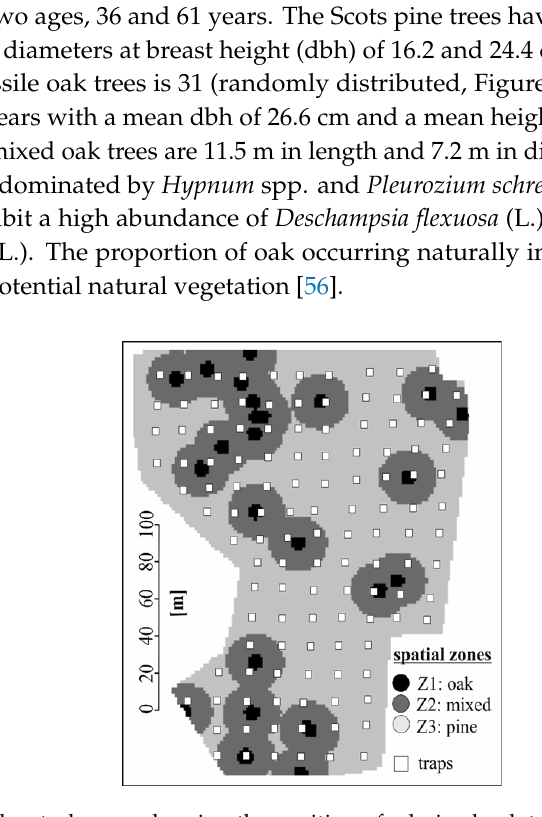
Figure 1. Map of the study area showing the position of admixed oak trees (black) within the pine forest (light grey) and the calculated tree effect zones (dark grey: oak–pine mixed zone). The squares forest (light grey) and the calculated tree e ff ect zones (dark grey: oak–pine mixed zone). The squares show the trap positions as a grid of 15 m × 15 m. show the trap positions as a grid of 15 m × 15